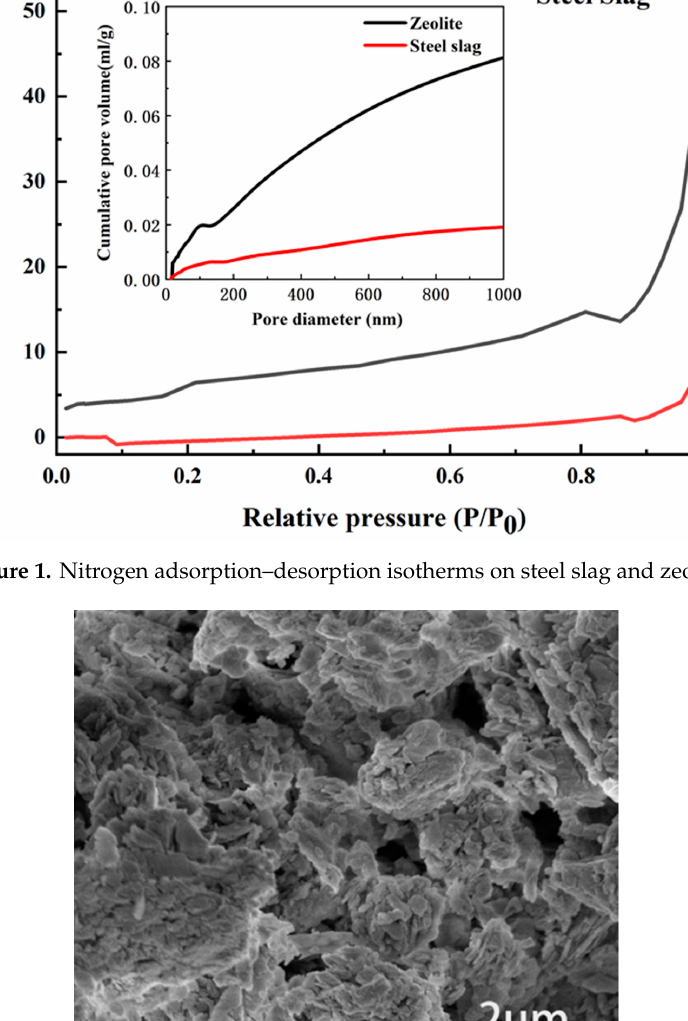
Table 2. Mineral content of raw materials (wt.%) . Sample